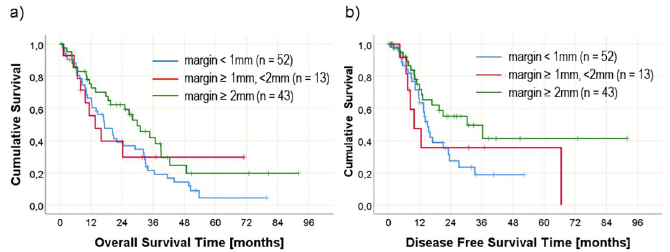
Fig 4. Overall survival (left side) and disease free survival (right side) over time in relation to involvement of the medial resection margin for three different resection margin distances. Numbers at risk are given in